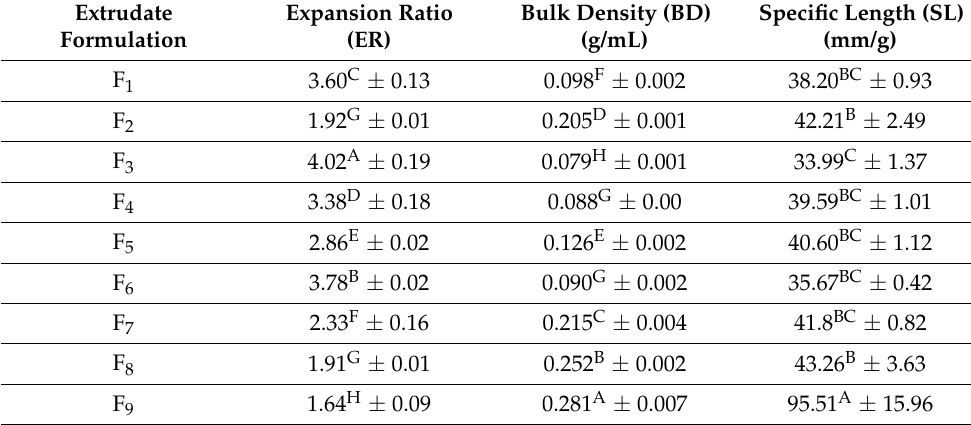
Table 5. Physical properties of neera honey incorporated